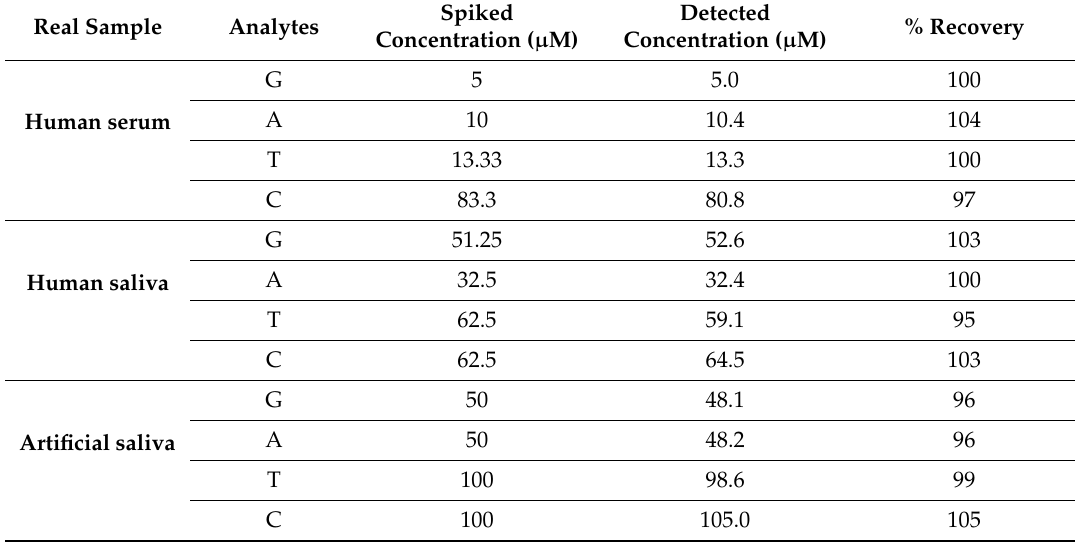
Table 3. Summary of simultaneous voltammetric detection studies using the spiked human serum, saliva, and artificial saliva samples at GCE / GO-MWCNT-CHT